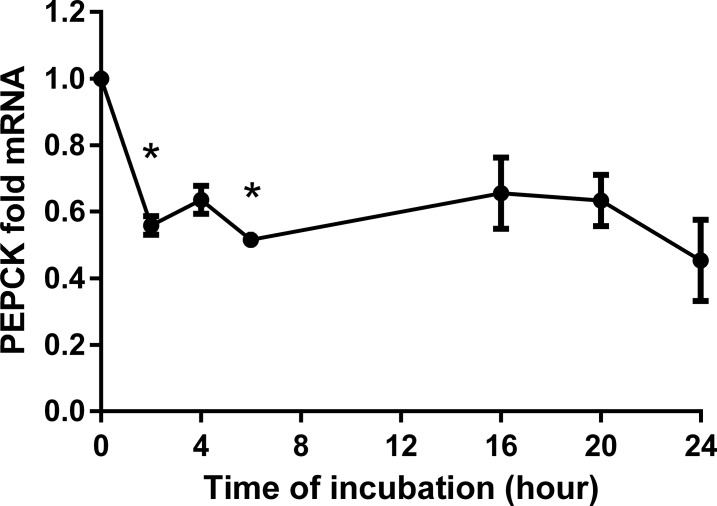
PEPCK time dependency analyses in HepG2 cells modulated by BITC.Time dependency analyses upon stimulation with BITC 30 μM is shown for PEPCK. Fold mRNA expression was normalized to the housekeeping gene RPL32 and control (0 hours), the control value is unity. One way ANOVA was used for the nonlinear regression analyses. Data shown as mean value ± SEM of gene expression versus control *(p<0.05).